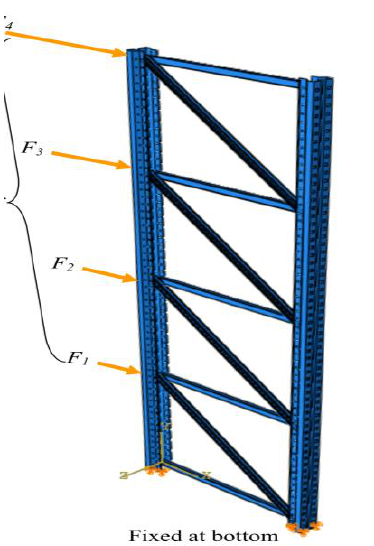
Figure 10: Boundary condition and loading for storage rack